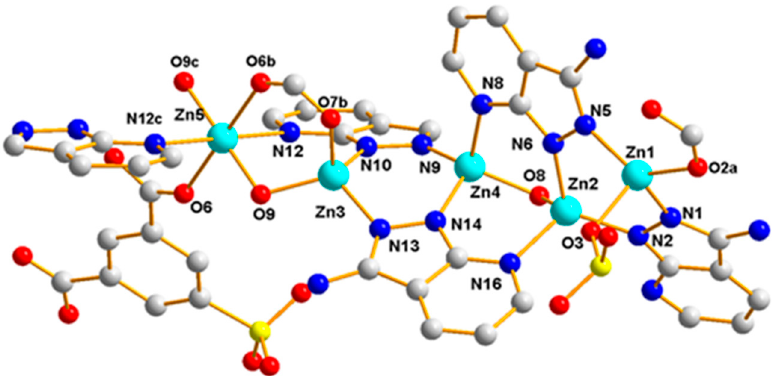
Figure 10. The coordination environment of the Zn(II) ions in Polymer 3. The hydrogen atoms have been omitted for clarity.